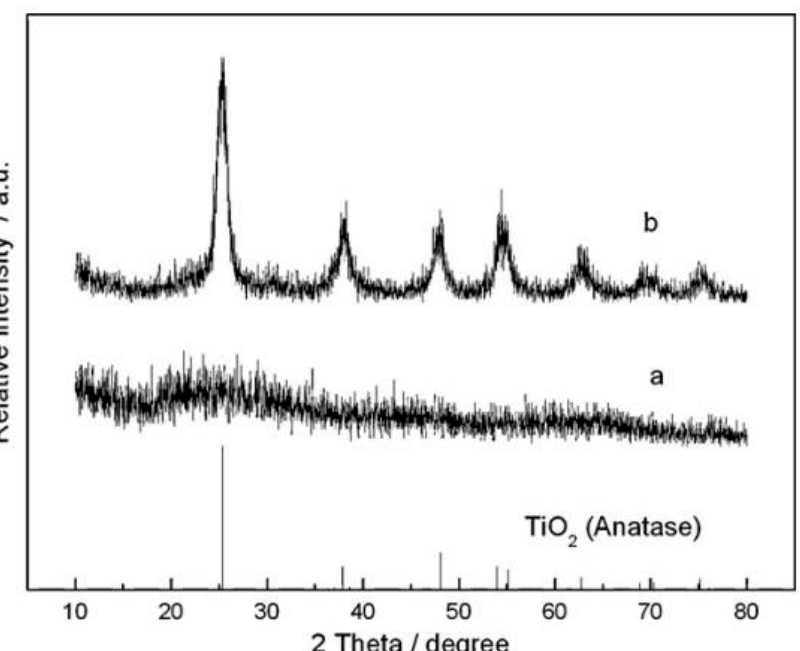
Figure 2. XRD pattern of the precursors with heat treatment (autoclaved) (represented as ‘a’ in the graph) and without heat treatment (represented as ‘b’ in the graph). Reprint with permission [54]; Copyright © 2009 Elsevier Ltd. All rights reserved.